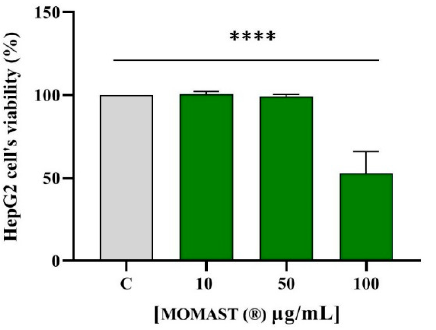
point of view, no significant difference was observed between MOMAST ® and pravas- Figure 2. Effect of MOMAST ® on HepG2’s cell viability. The data points represent the averages ± tatin. SD of three experiments in triplicate, (****) p < 0.0001 vs. control (C).